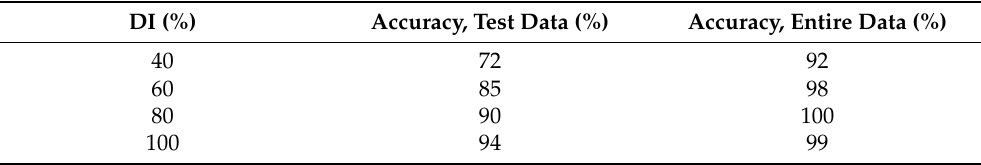
Figure 5. Confusion matrix for model M 1 as target at DIs ( a ) 40%, ( b ) 60%, ( c ) 80%, and ( d ) 100%. Table 3. Coupled POD JDA–kernel Accuracy, Target: M 1 .